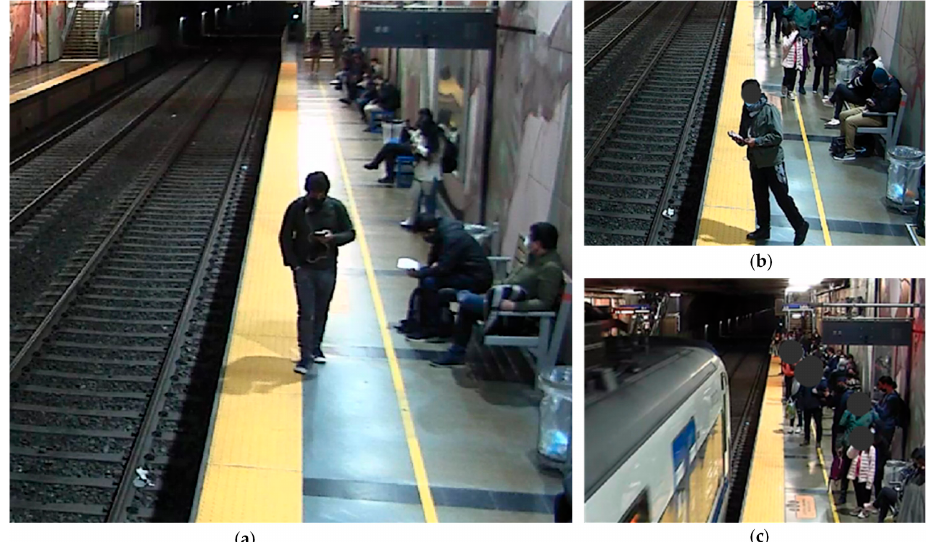
Figure 6. Instants of time to study the behavior at the platform train interface in Valparaiso Metro: ( a ) first instant of time in which passengers access the platform; ( b ) second instant of time when passengers walk closer to the yellow safety line; and ( c ) third instant of time when the train approaches and passengers move toward the yellow safety line at the platform edge.